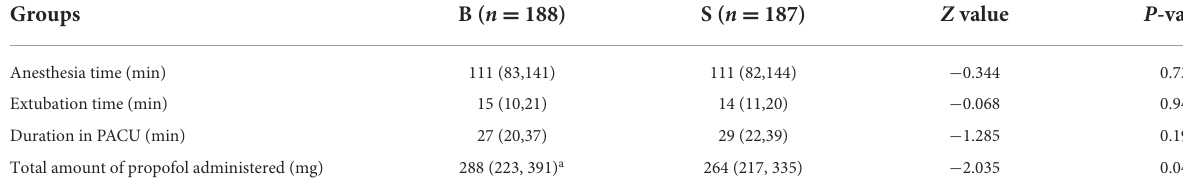
TABLE 3 Anesthesia time, extubation time, duration of PACU stay, and total propofol administered in the bispectral index (B) and standard of care (S)